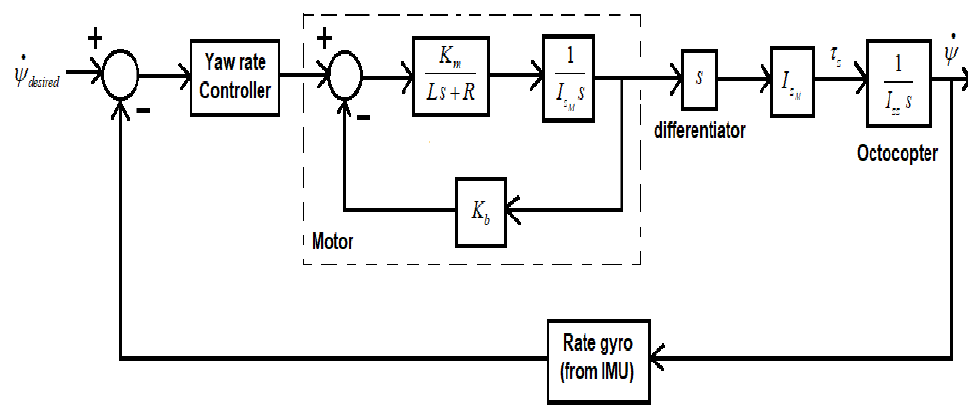
Figure 11. Yaw rate control loop.